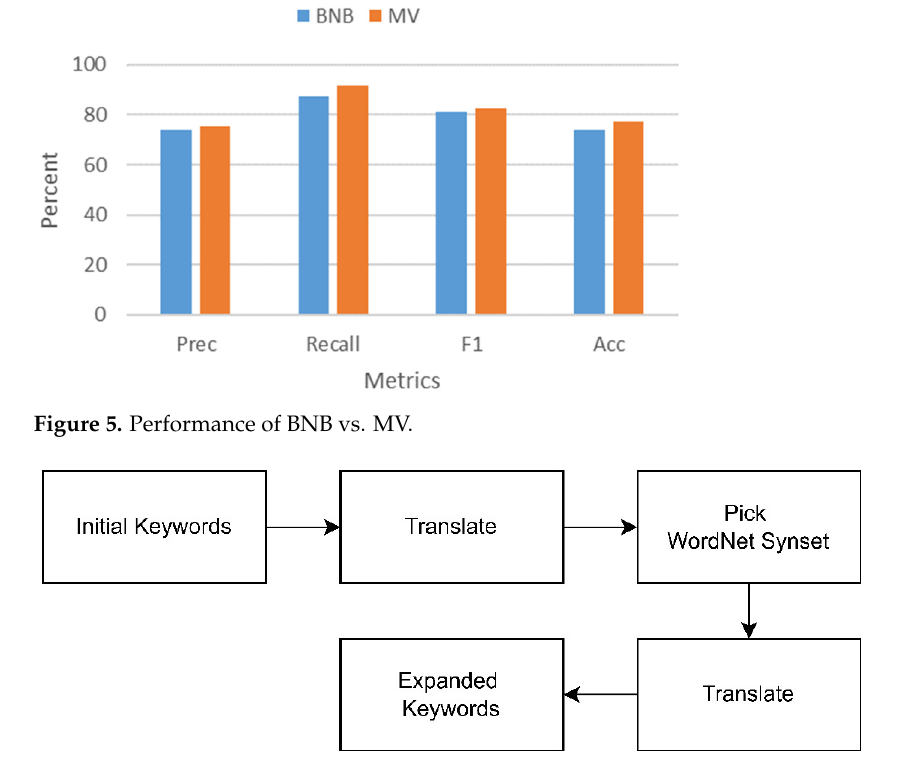
Table 5. The results of the expanded keywords.